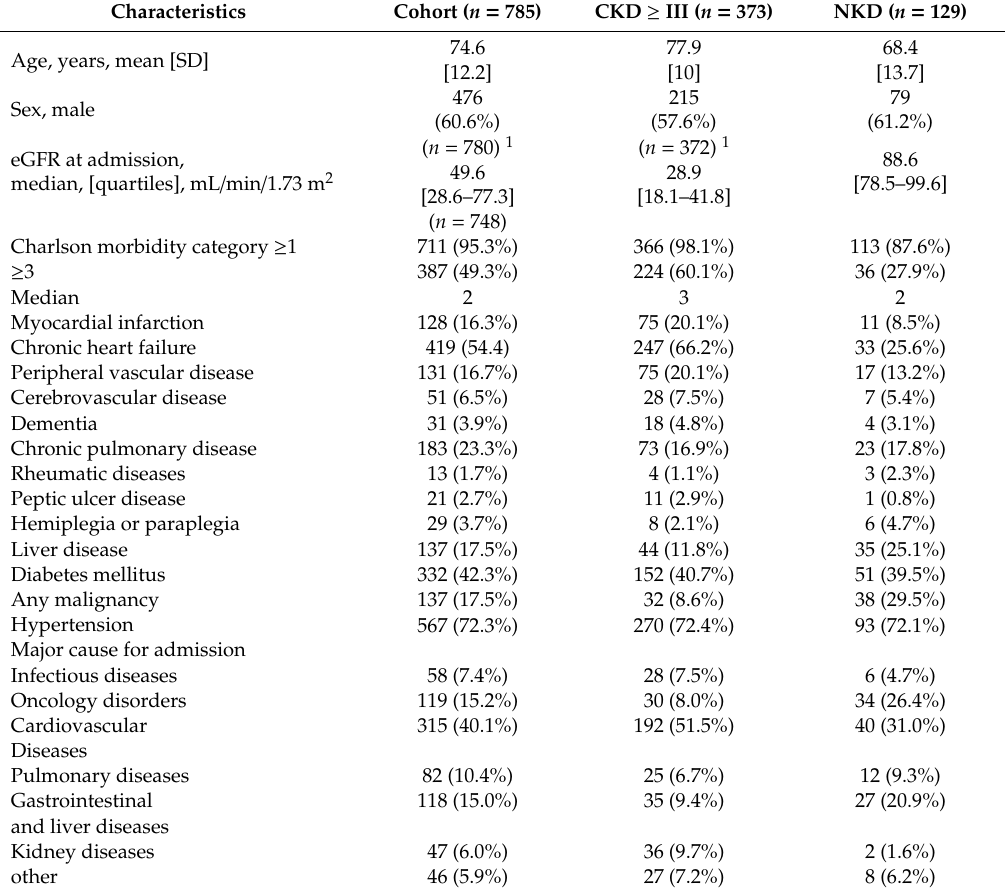
Table 1. Epidemiological Characteristics from all Individuals and from Individuals with CKD ≥ III or NKD Identified by the Reference Standard,